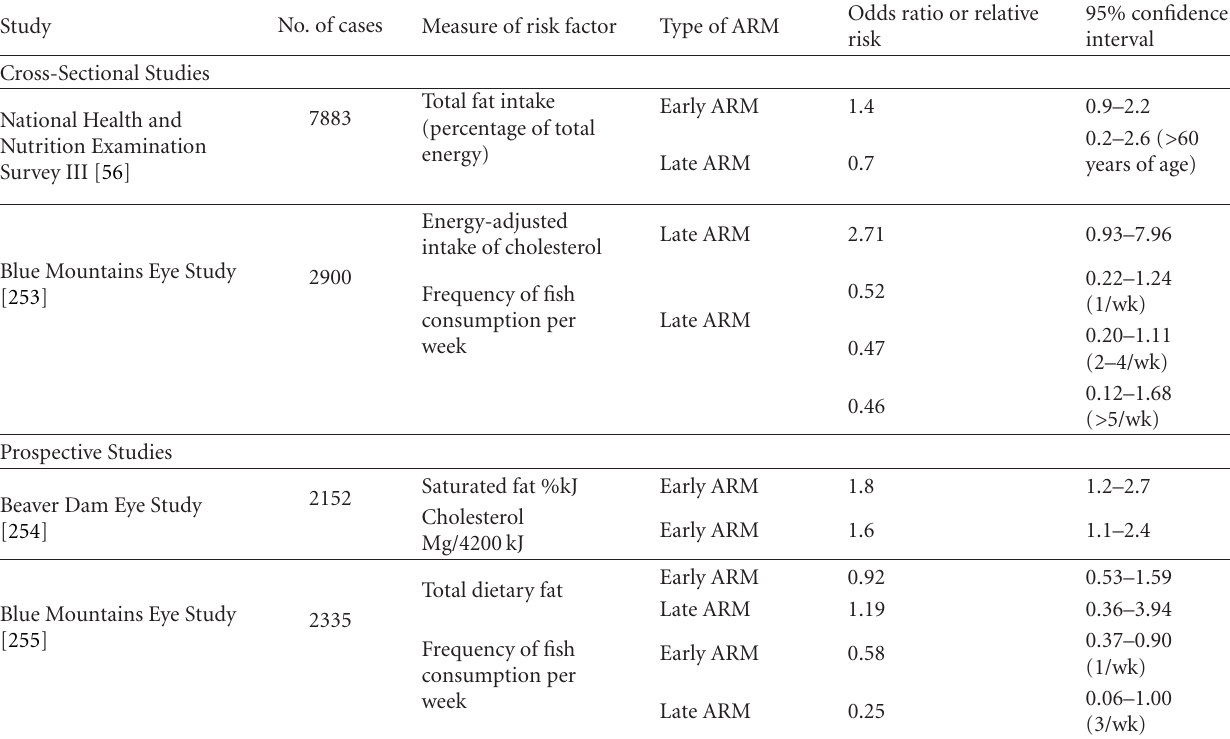
Table 14: Studies investigating the relationship between dietary fat/fish intake and risk for